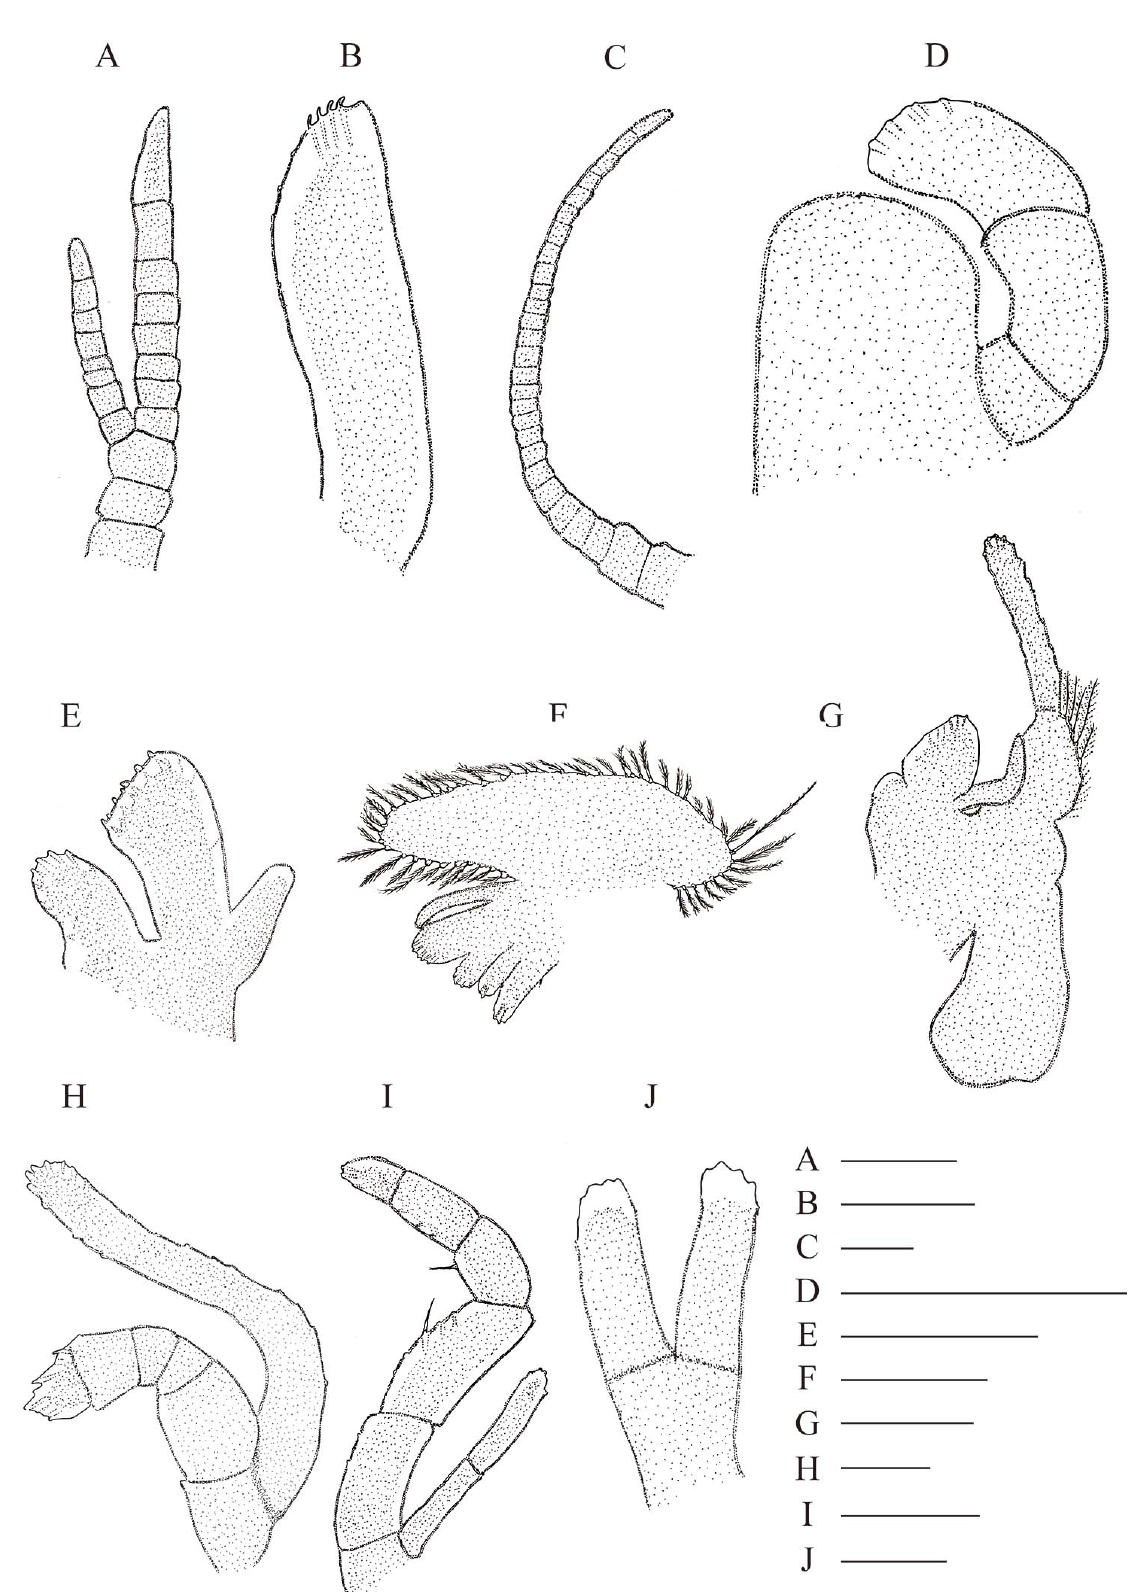
Figure 20. Juvenile Stage I of Cherax destructor . ( A ) Antenna 1, dorsal view; ( B ) antennal scale, dorsal view; ( C ) antenna 2, dorsal view; ( D ) mandible, view of inside of mouth; ( E ) maxilla 1, oral view; ( F ) maxilla 2, oral view; ( G ) first maxilliped, oral view; ( H ) second maxilliped, oral view; ( I ) third maxilliped, oral view; ( J ) pleopod. Scale bars: 0.25